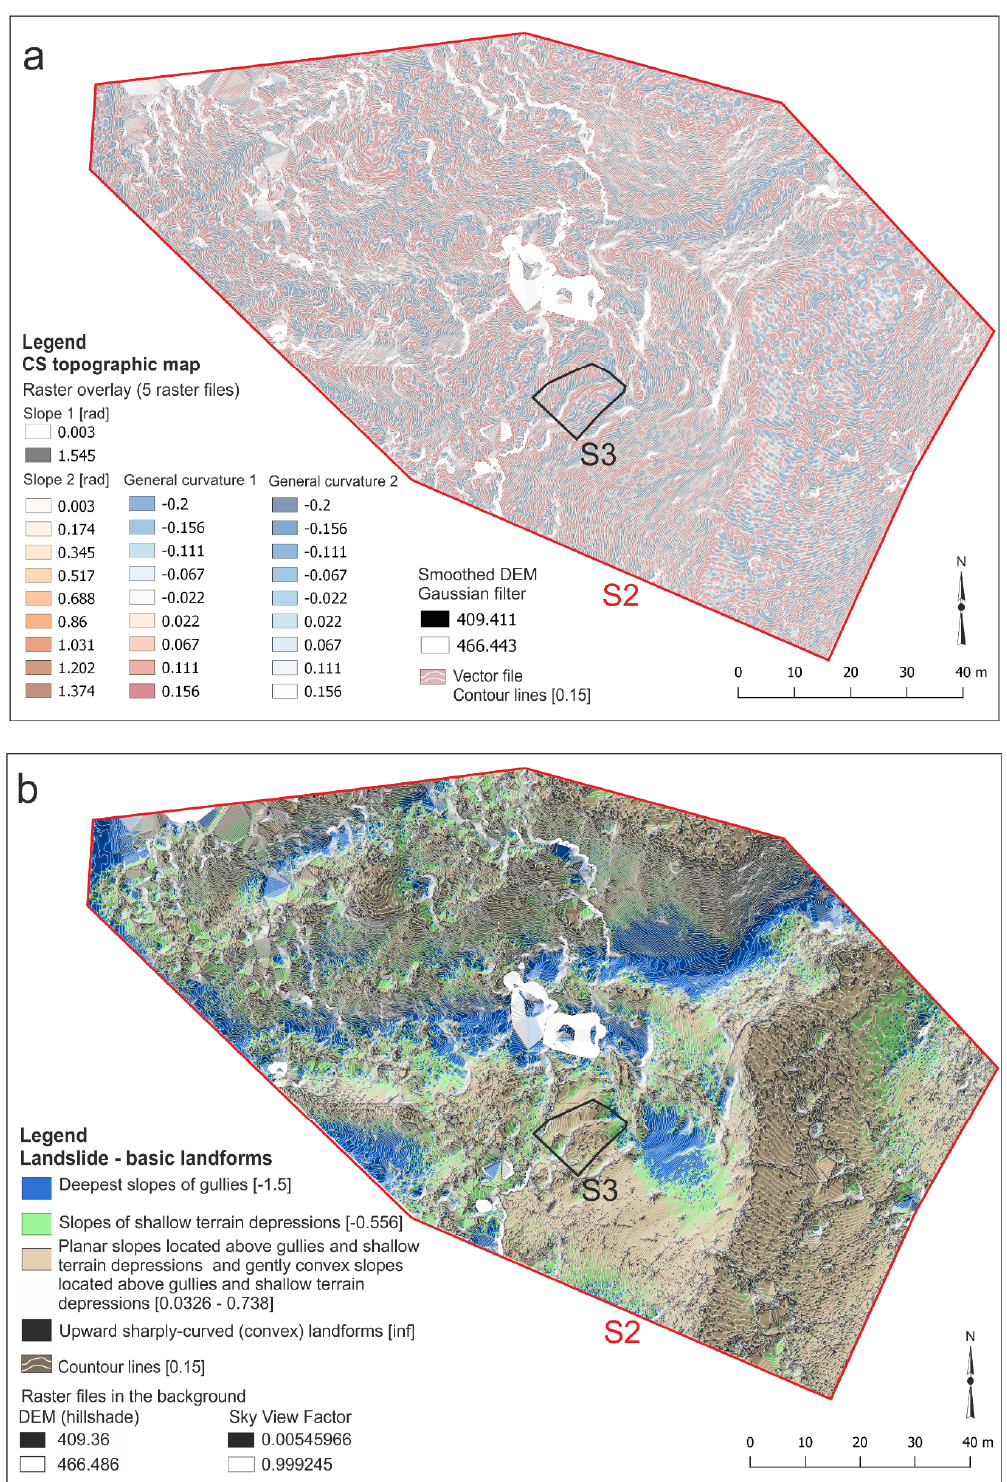
Figure 4. Delineation of a gully related landslide system in a DEM generated from point clouds acquired by aerial laser scanning using the RPAS technology applying the ( a ) CSMapMaker QGIS plugin and ( b ) Raster operation. The depth of valleys was deducted from multiplied raster files of maximal curvature and sky-view factor, and the output raster indicates basic landforms of the investigated landslide.